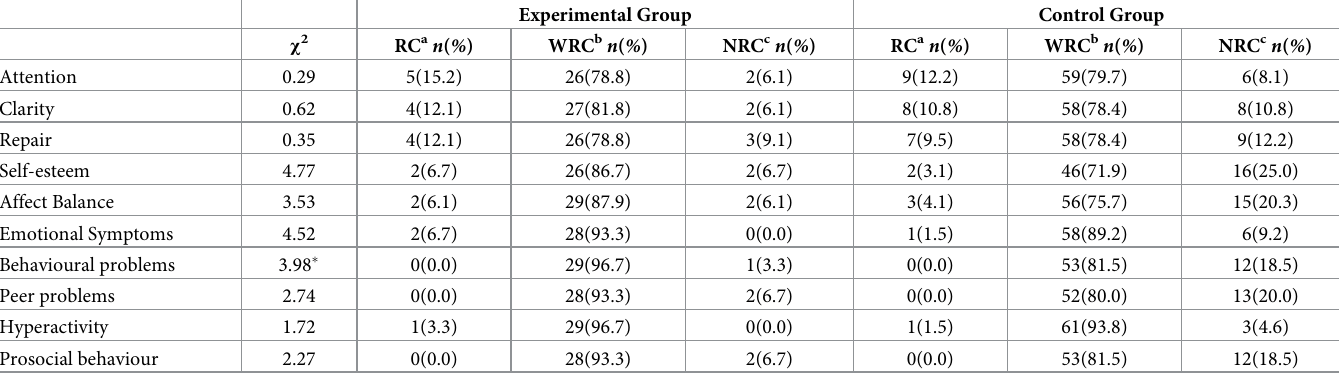
Table 5. Reliable change index pre-intervention to